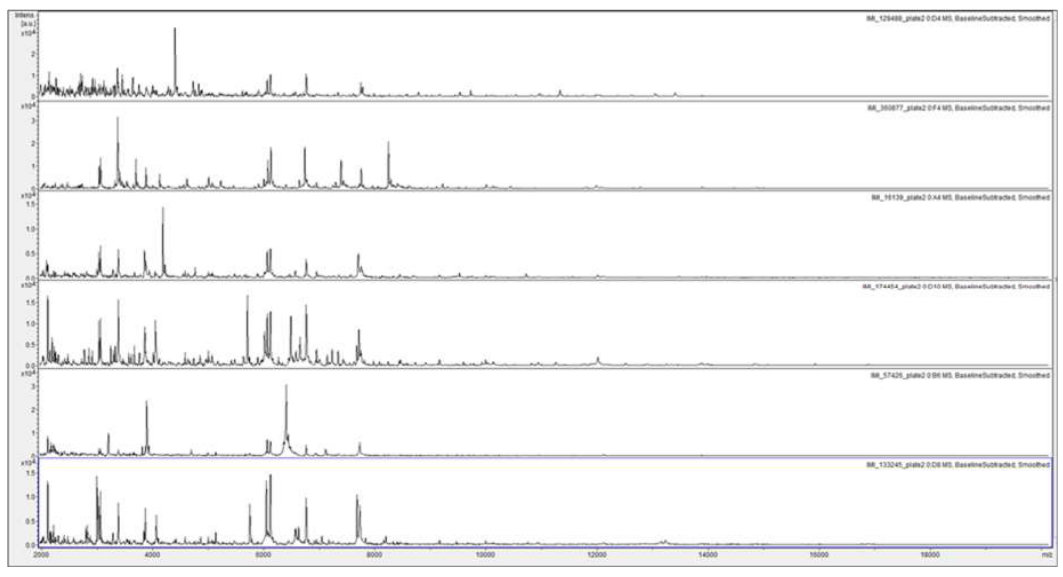
Figure 4. MALDI-TOF MS spectra of acid-soluble fungal proteins from plate-2 examples of, from top to bottom, SLG 1 (IMI 129488), SLG 2 (IMI 360877), SLG 3 (IMI 16139), SLG 4 (IMI174454), SLG 5 (IMI 57426), and SLG 6 (133245).